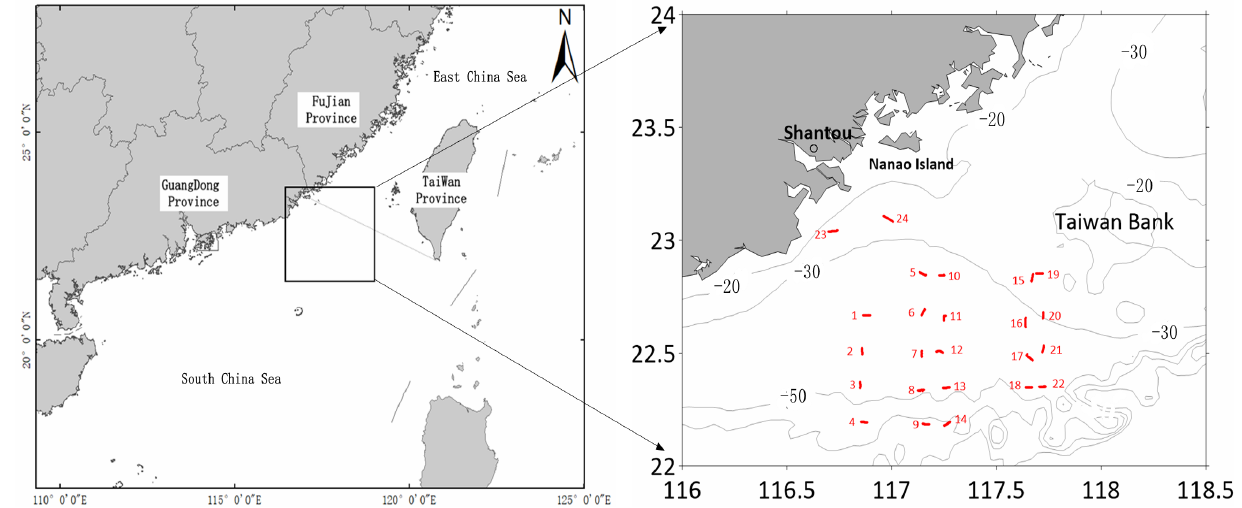
Figure 1. Map of study area and acoustic survey transects. The black box represents the study area, and rea lines represent the acoustic route.